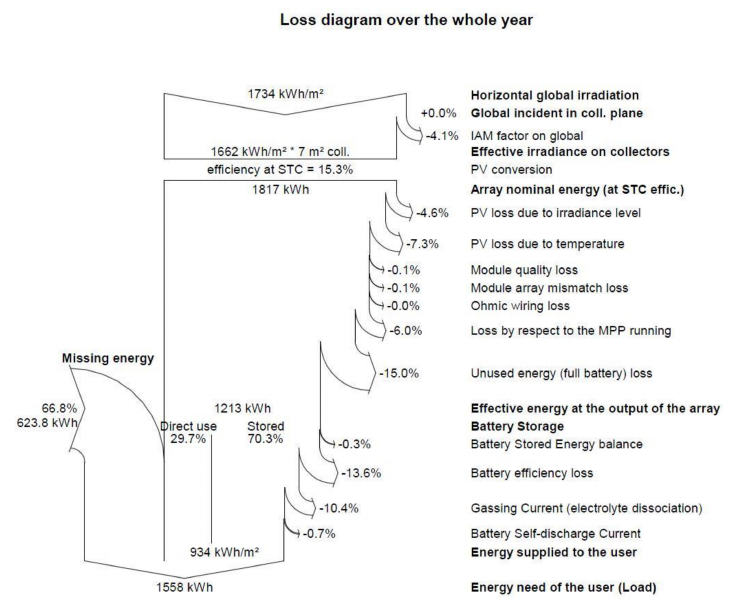
Figure 14. Energy losses of the PV system, balance between final photovoltaic energy generation and total demand, showing the requirement for a back-up generating system. (Performed with PVSYST V5.05).